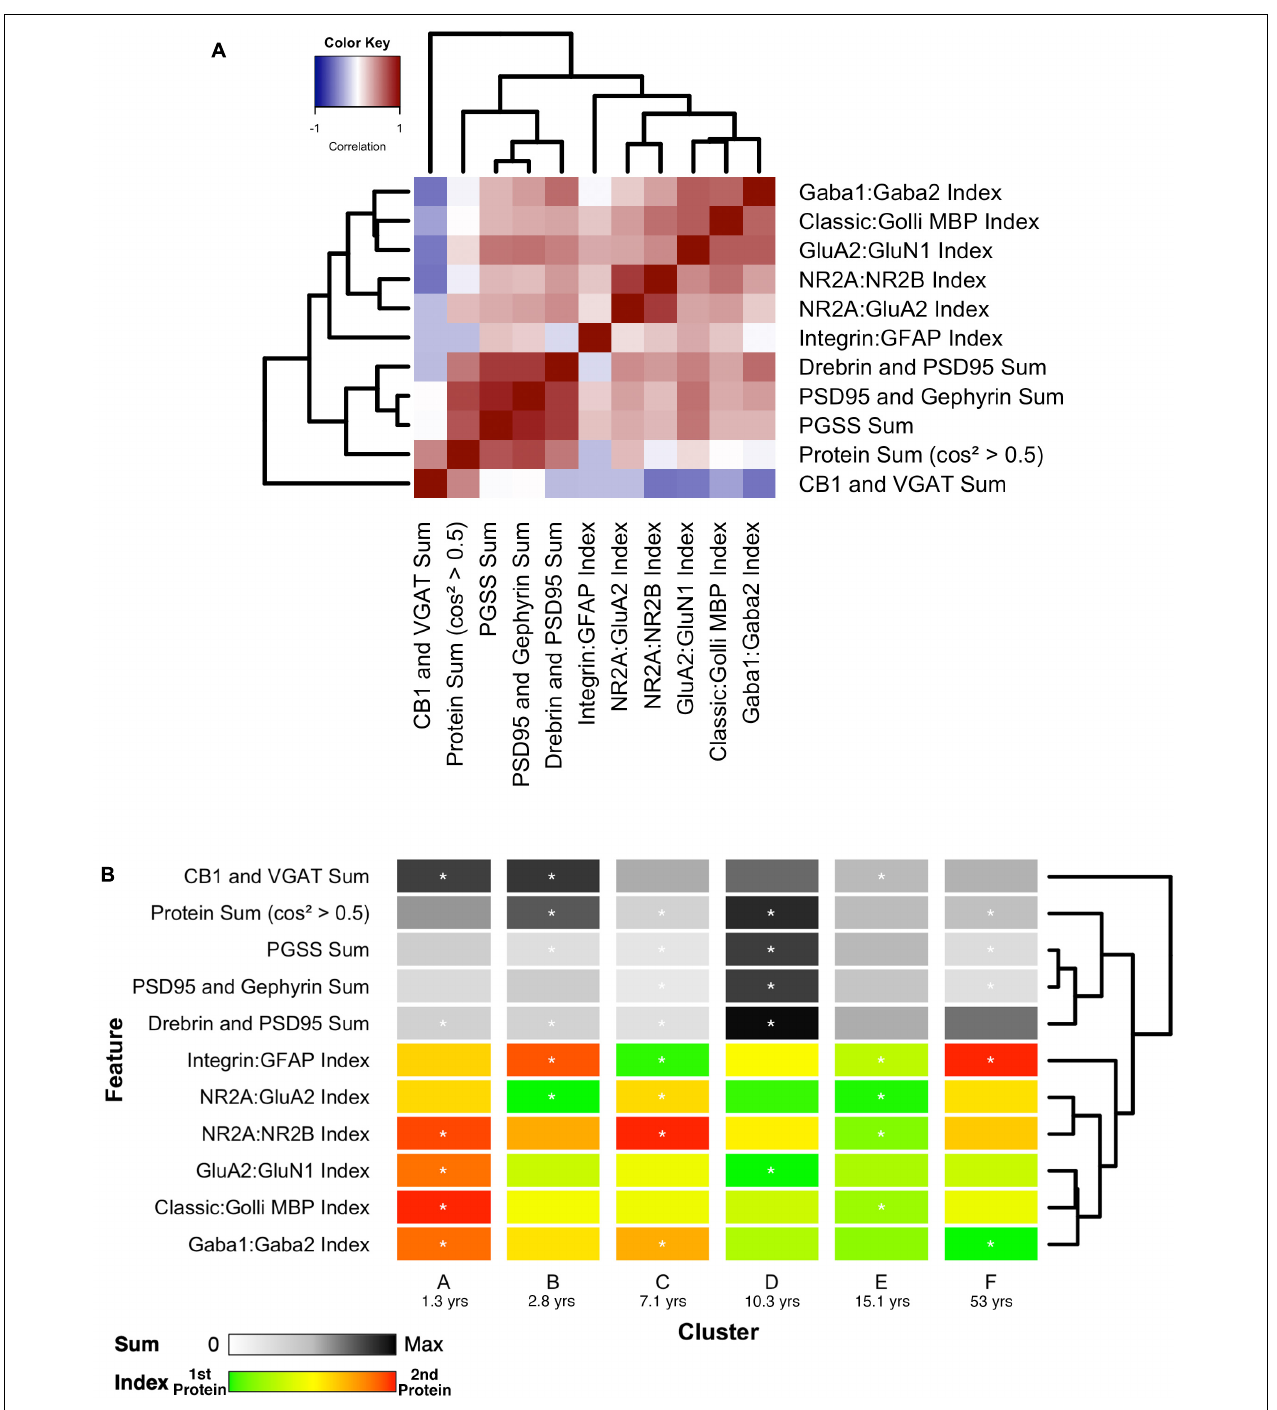
FIGURE 14 | Associations between selected features and feature phenotype by cluster. (A) Correlation heat map between protein sums and indices, with strength and direction of Pearson’s R correlation represented by the color (negative = blue, zero = white, positive = red), and arranged by similar pairwise correlations using a wrapped dendrogram. Features were selected if they were significantly correlated with any of the first three PCA dimensions. (B) The plasticity phenotype was visualized using color-coded horizontal bars representing the median expression of selected features across clusters. For protein sums, the color ranges from white (zero) to gray (midpoint) to black (maximum protein sum across all features). For the protein indices, the color ranges from green (favoring the first protein in the index) to yellow (balance of the two proteins) to red (favoring the second protein in the index). Asterisks indicate features that were found to be either over- or under-represented. The features are arranged according to the same dendrogram generated in (A)